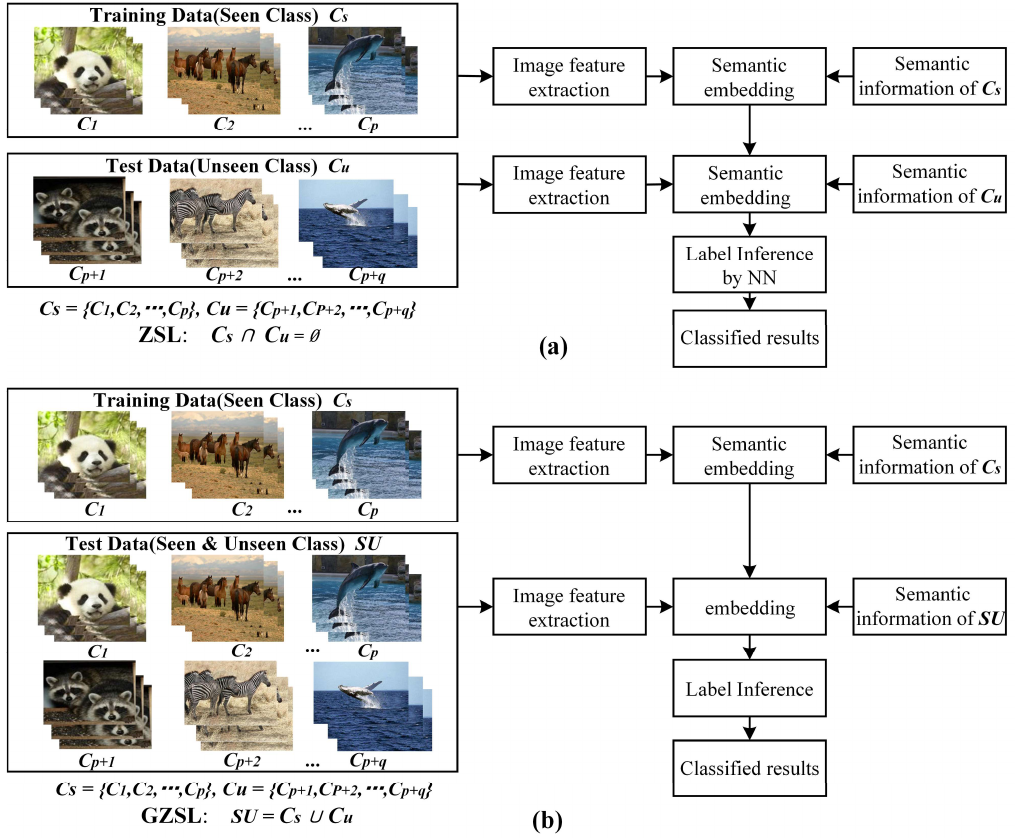
Figure 1. The comparative illustration of the conventional ZSL framework and GZSL framework: ( a ) the conventional ZSL framework; and ( b ) the GZSL framework.